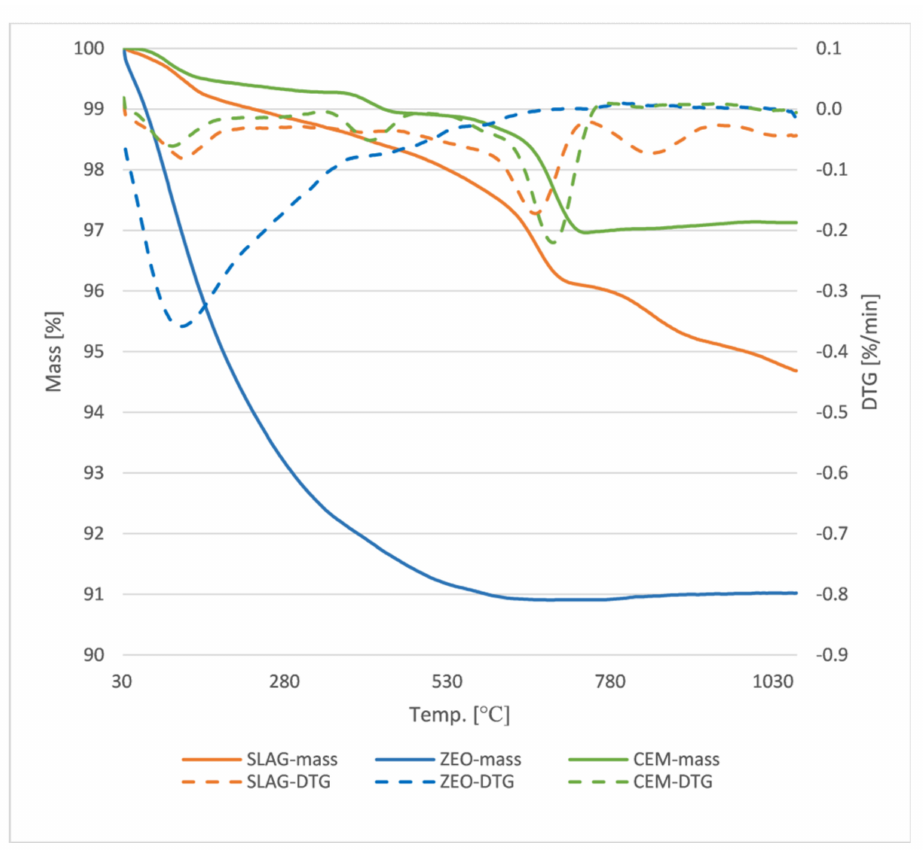
Figure 2. TG/DTG characterization of slag, zeolite and cement.